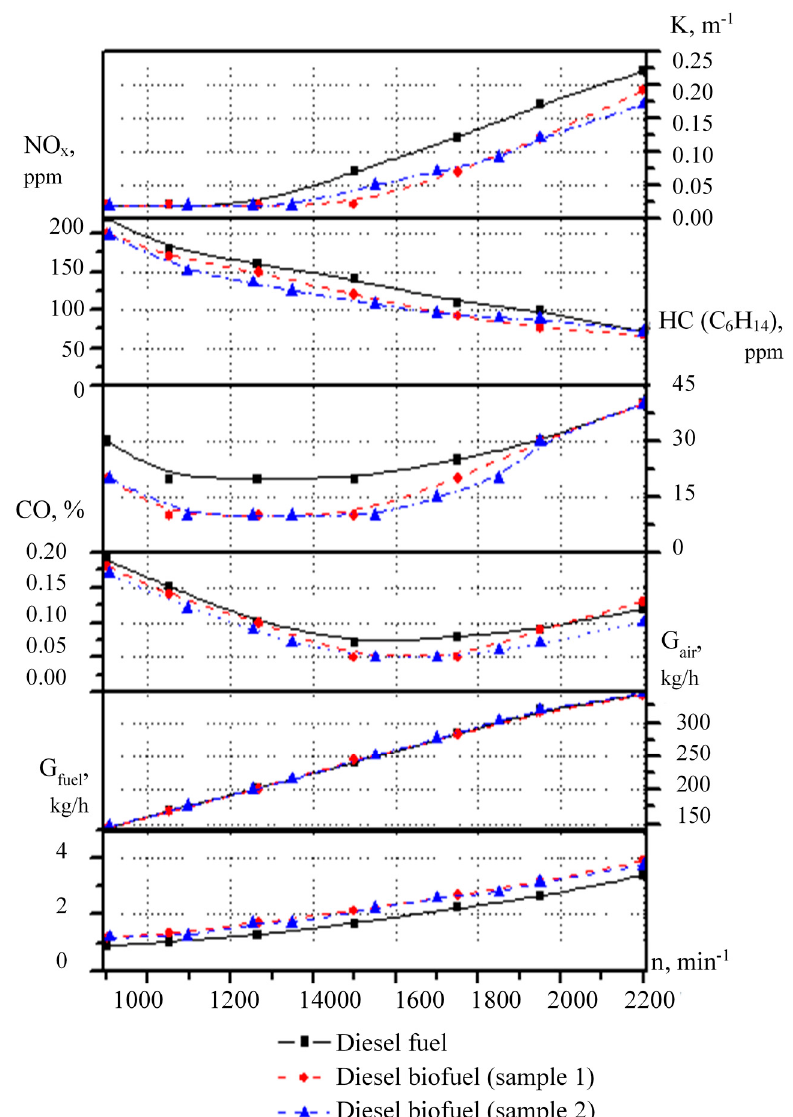
Figure 4. Idle characteristics of the D-241 diesel engine.